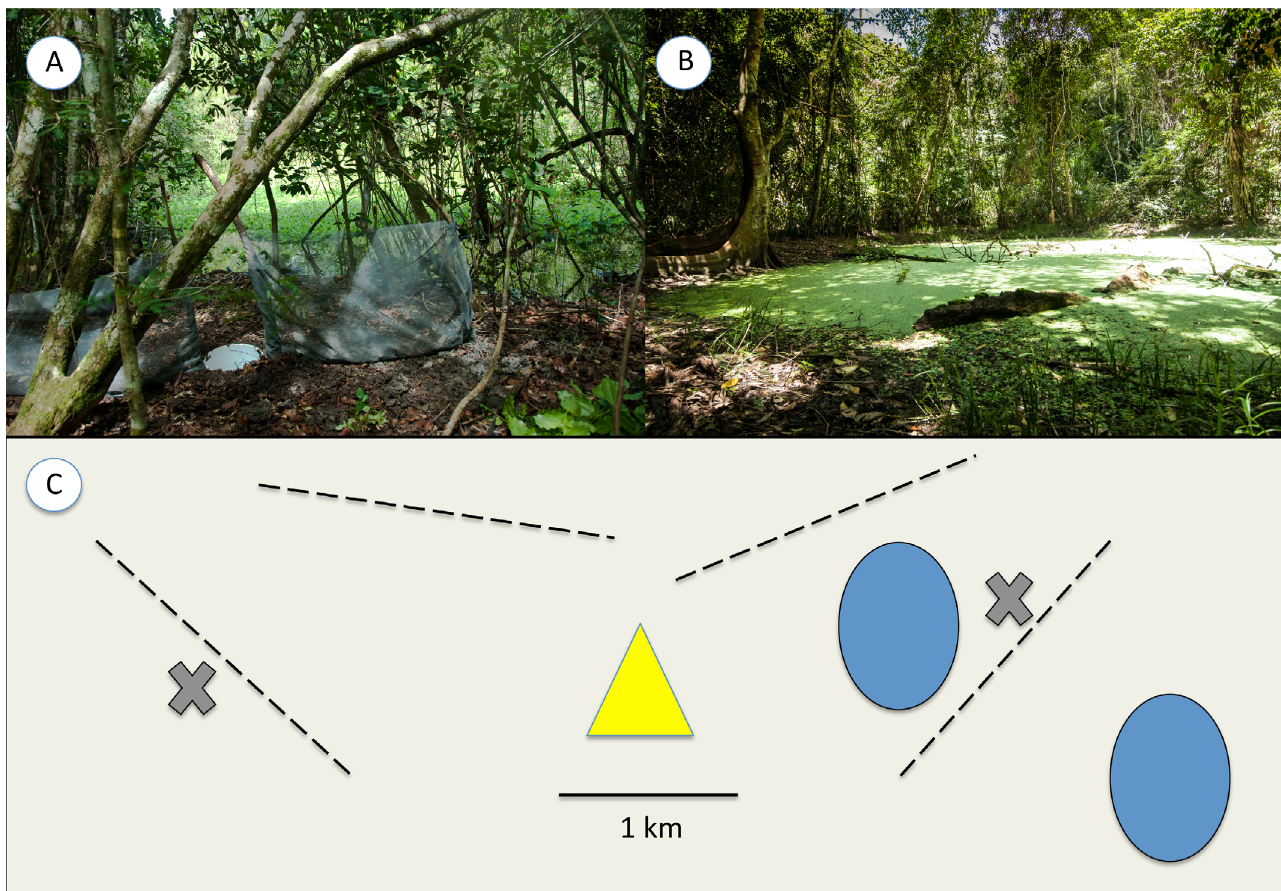
Figure 2. ( A ) Example of pitfall trap and drift fence array. ( B ) Typical semi-permanent aguada. ( C ) Graphical representation of transect and trap design where camp is indicated by yellow triangle, transects by dashed lines, aguadas by blue circles and pitfall and drift fence arrays by